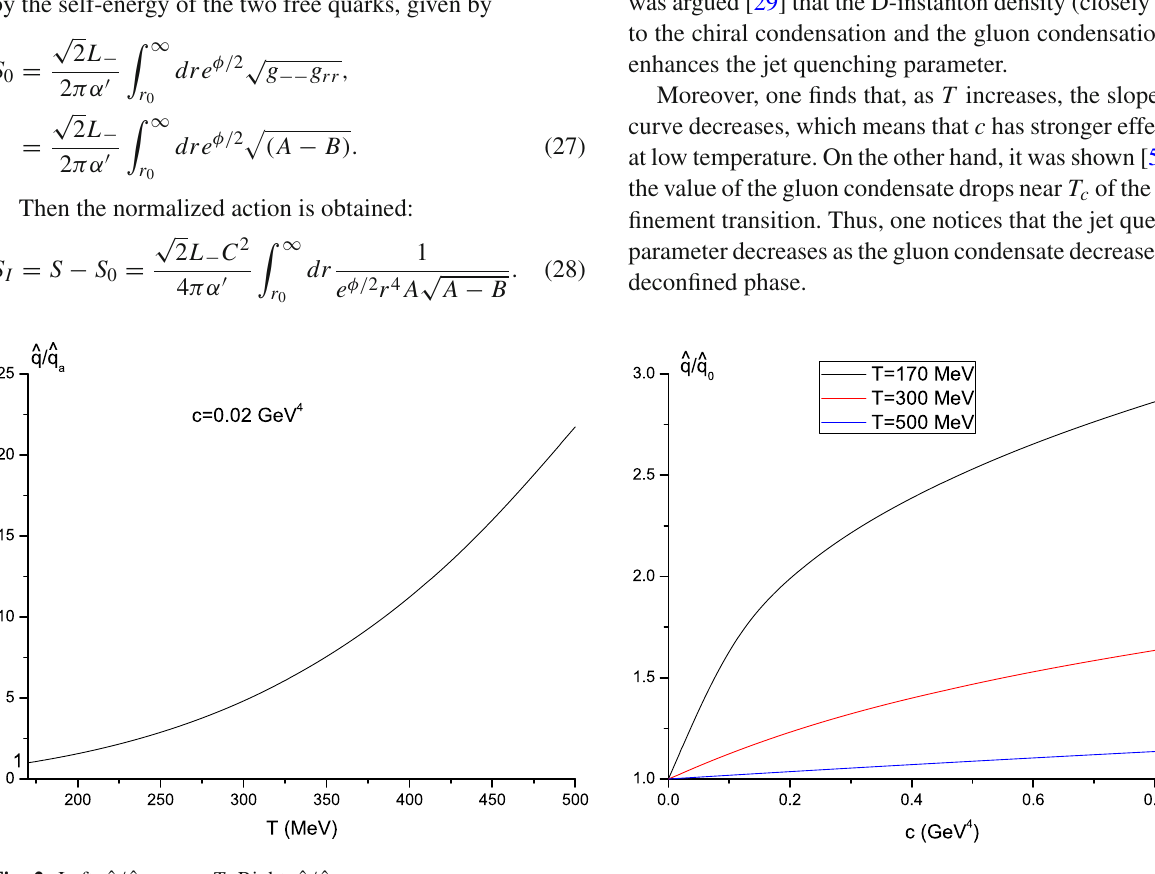
Fig. 2 Left: ˆ q / ˆ q a versus T . Right: ˆ q / ˆ q 0 versus